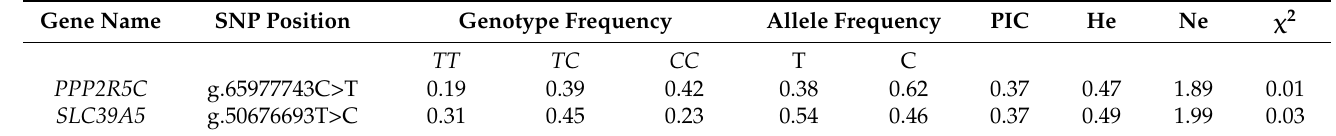
Table 5. Genetic characterization of Yunshang black goats.